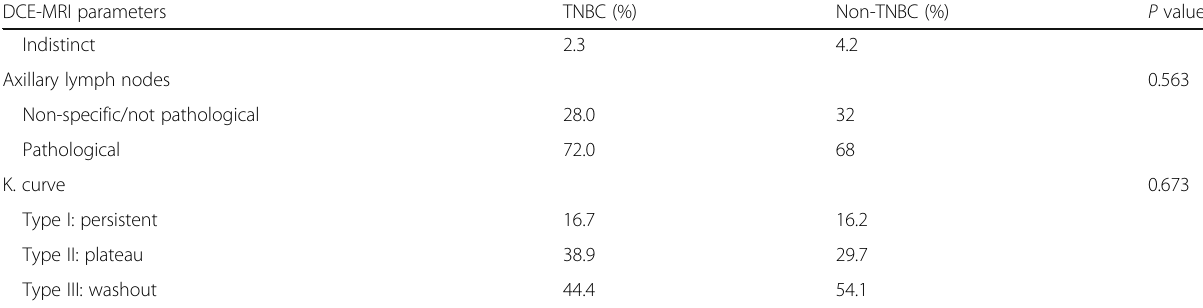
Table 2 DCE-MRI features of TNBC compared to other subtypes of breast cancer (non-TNBC) (Continued) DCE-MRI